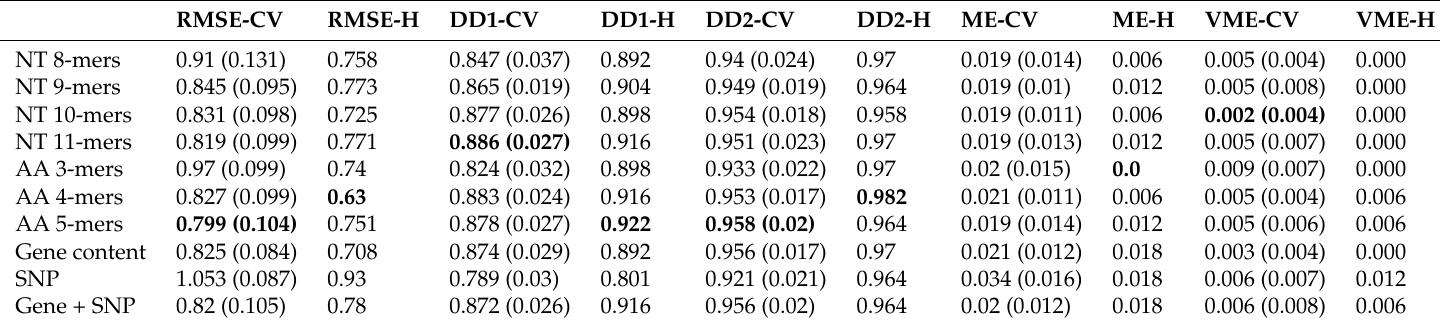
Table A36. K. pneumoniae